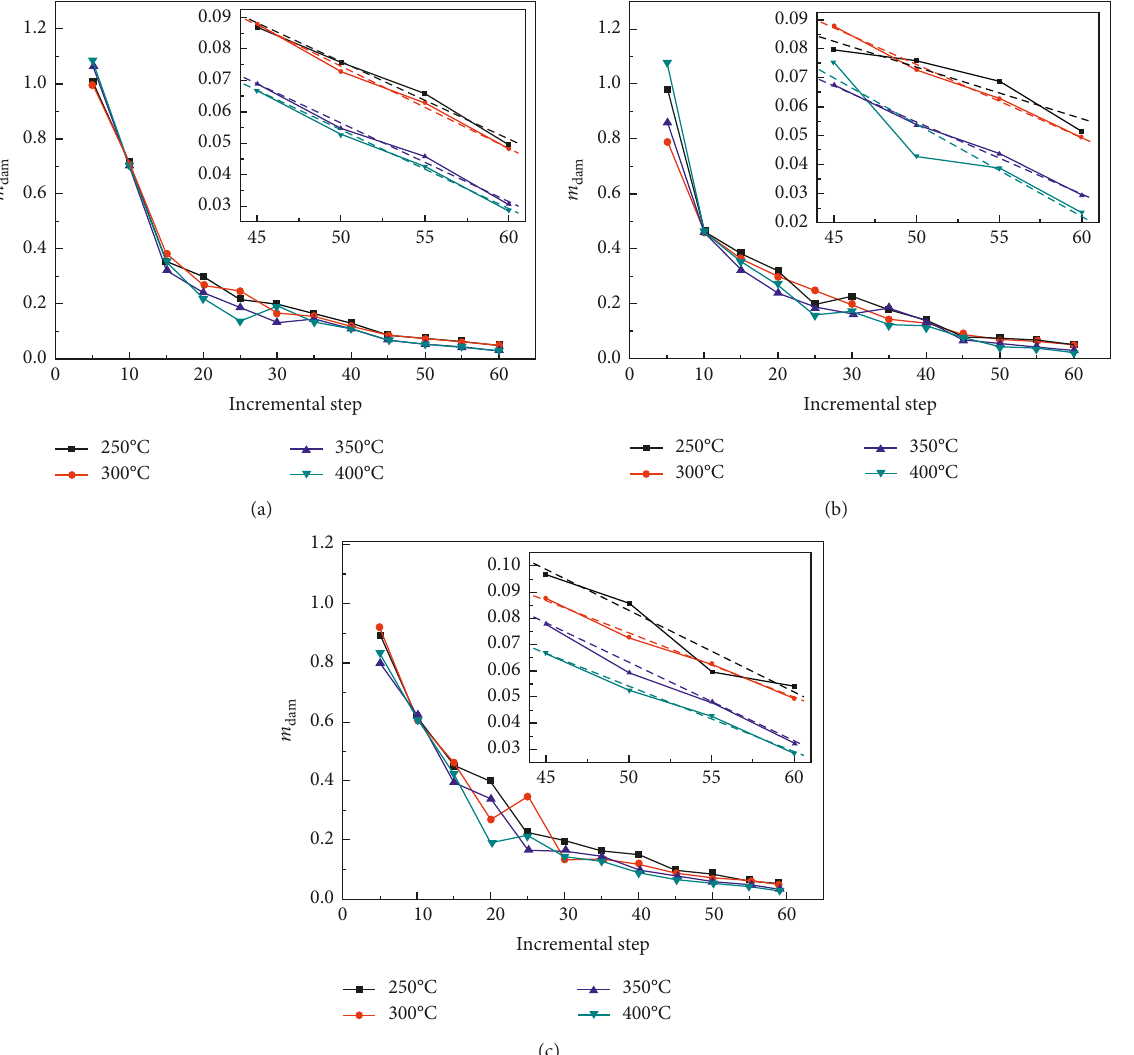
Figure 7: Variation in the damage sensitive rate on the outer edge of the upsetting drum at different temperatures and strain rates. Greater details of the graphs from (a)–(c) above 40 increment steps are shown in insets. (a) _ ε � 0 . 01s − 1 ; (b) _ ε � 0 . 1s − 1 ; (c) _ ε � 1s − 1